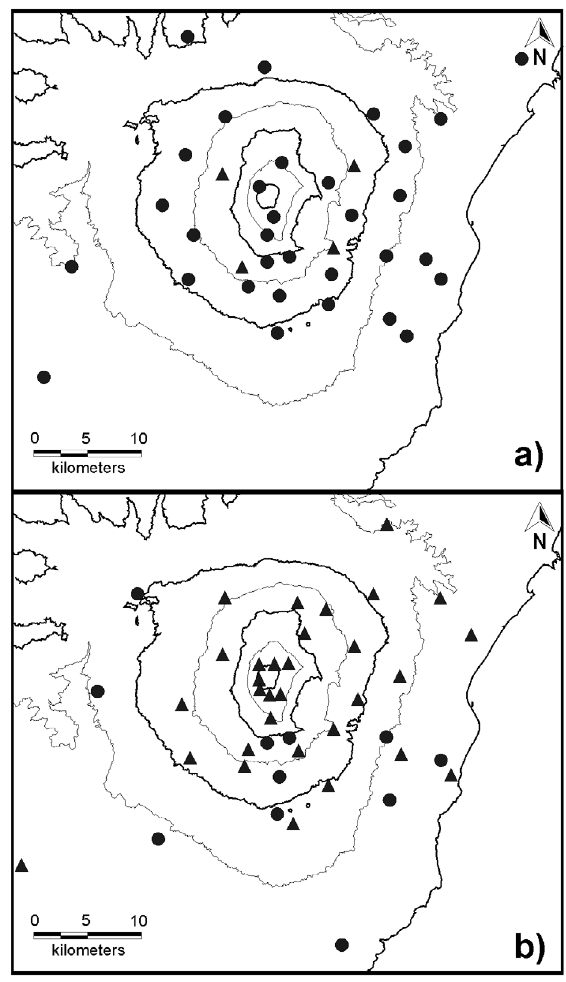
Figure 2. Two seismic network configuration over the time: (a) Po- seidon Project (1994-2000); (b) Istituto Nazionale di Geofisica e Vul- canologia - Osservatorio Etneo - Sezione di Catania (INGV-OE; 2001- present day). Black dots and triangles indicate one and three component seismic stations,